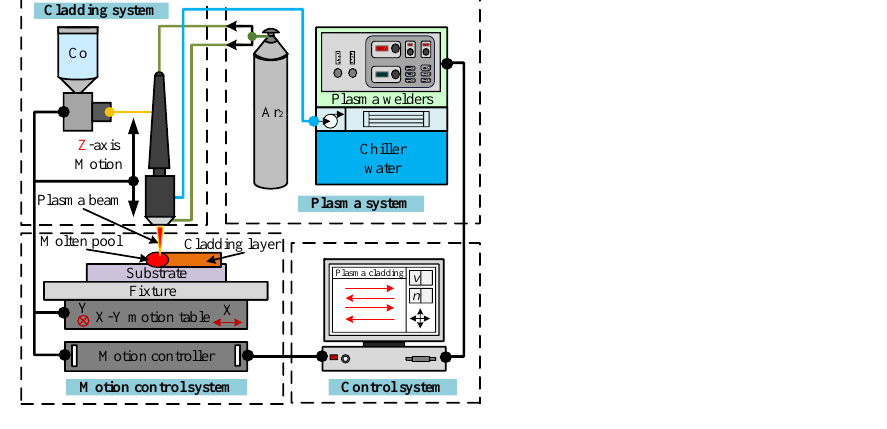
Table 3. Process parameters of the plasma